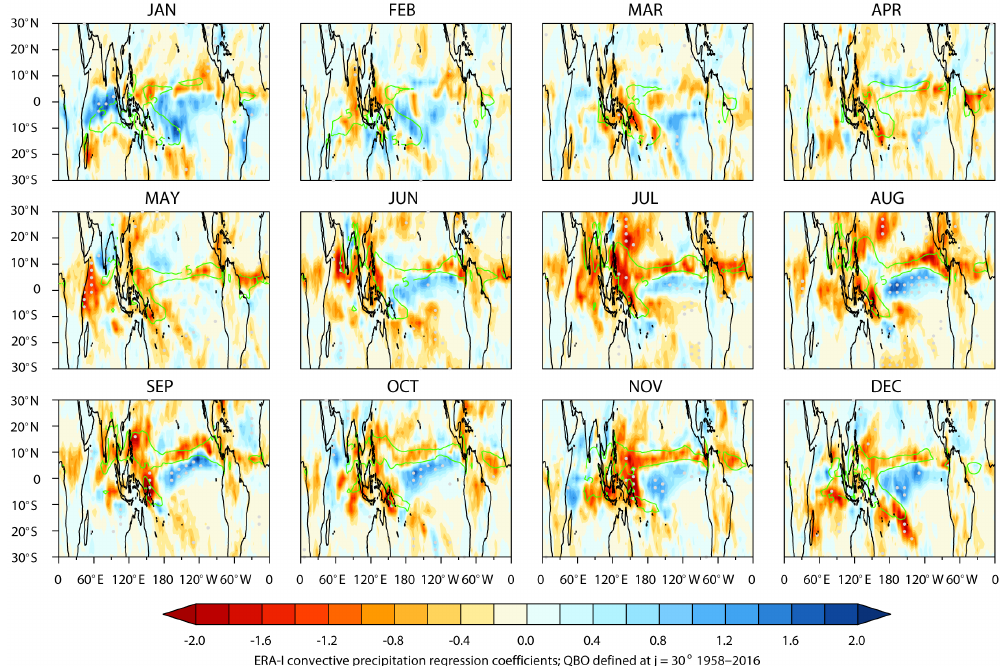
Figure 11. As Fig. 10 but using φ = + 30 ◦ , which is approximately equivalent to defining the QBO by U eq =